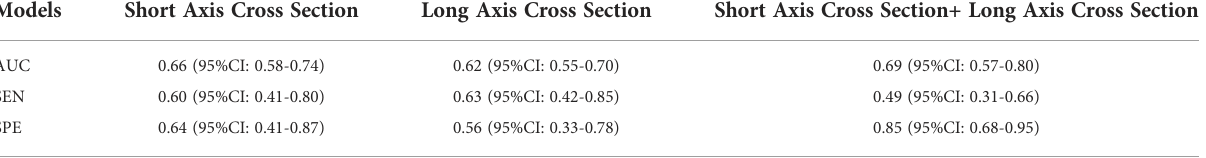
TABLE 2 The performance of radiomics models to predict central cervical LN metastasis of PTC based on extracted features in different sections. Models